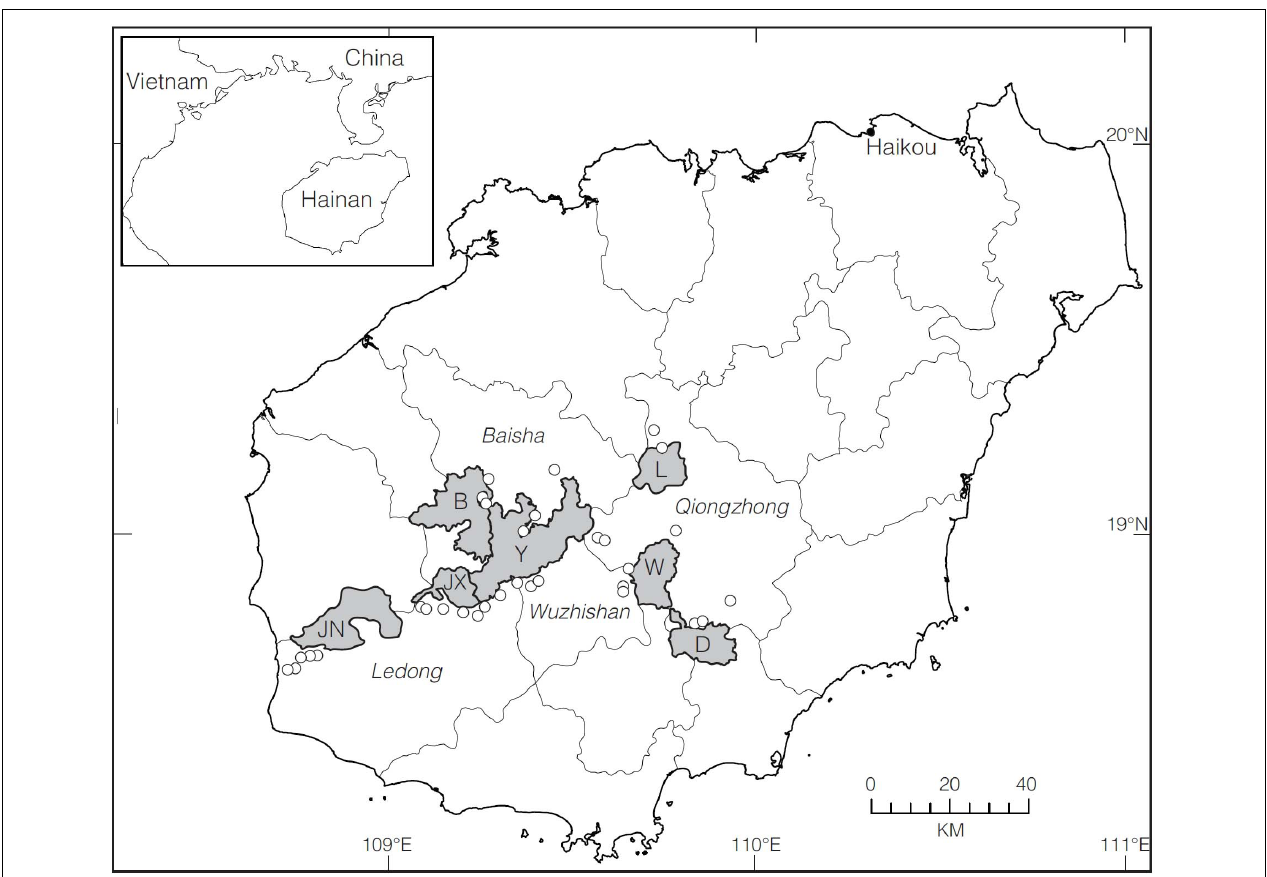
FIGURE 1 | Locations of 42 villages around nature reserves in Hainan included in this study.